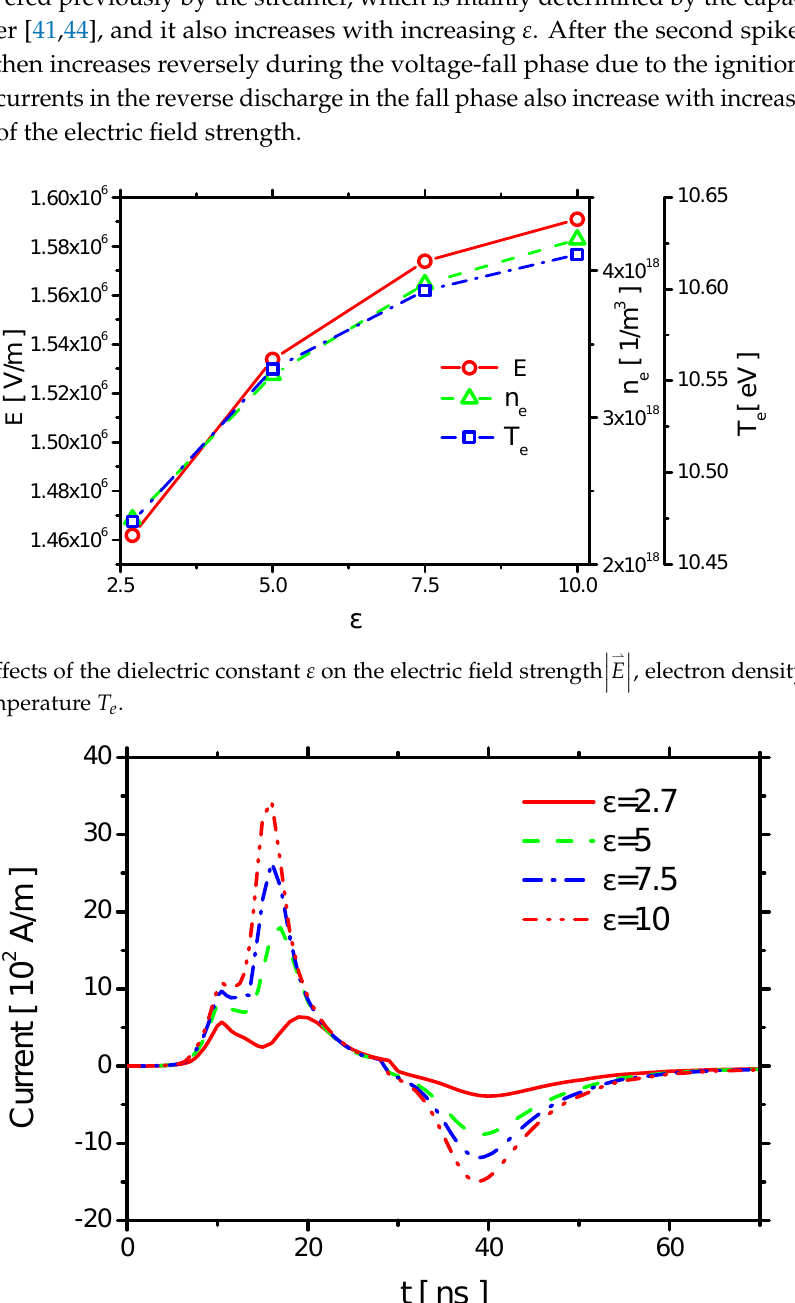
Figure 3. Effects of ε on the